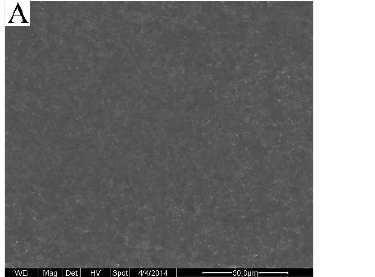
Figure 2. The membrane resistance distribution of adsorption ( a ) HMR-PVDF ( b ) HTR-PVDF.